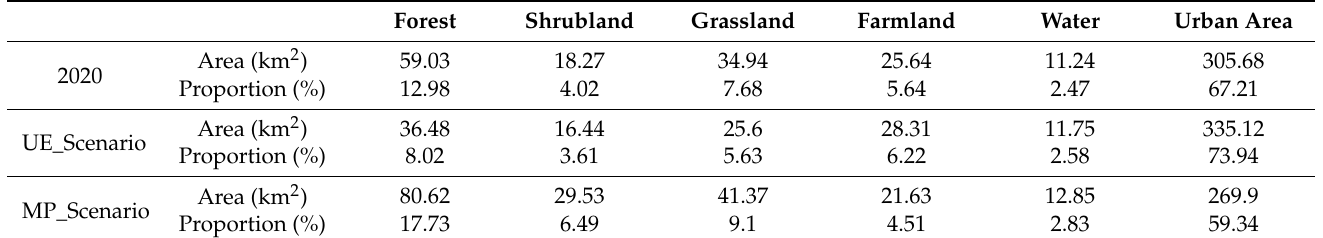
Table 3. Area and proportion of each type of land use in 2020 and under two scenarios. Forest Shrubland Grassland Farmland Water Urban